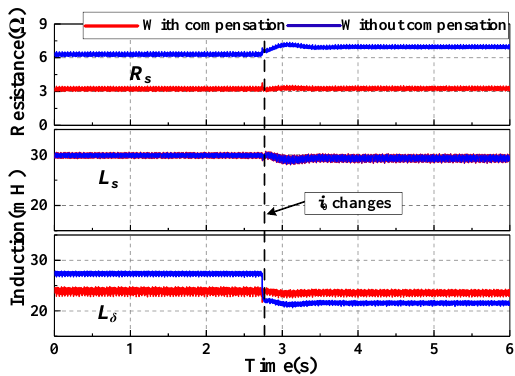
Figure 14. Nonlinearity Compensation ( i 0 changes).